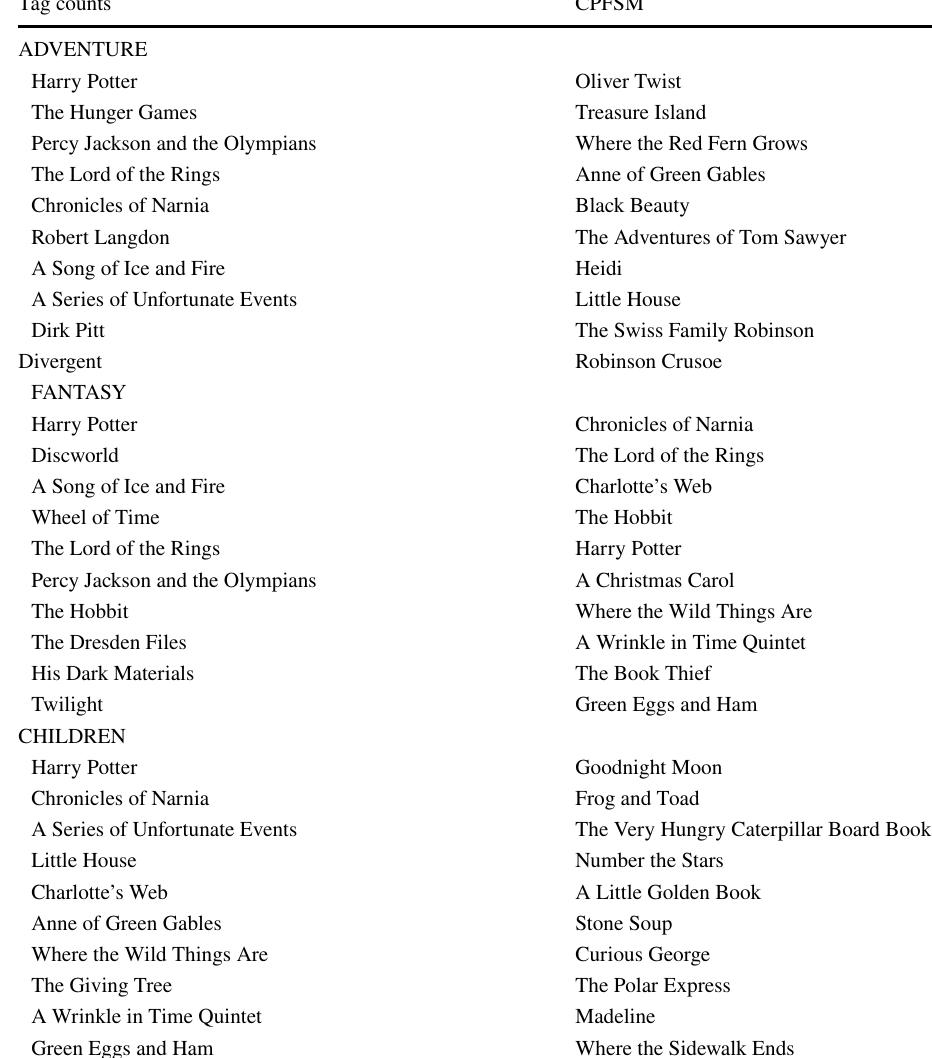
Table 4 Tag rankings for Goodbookss